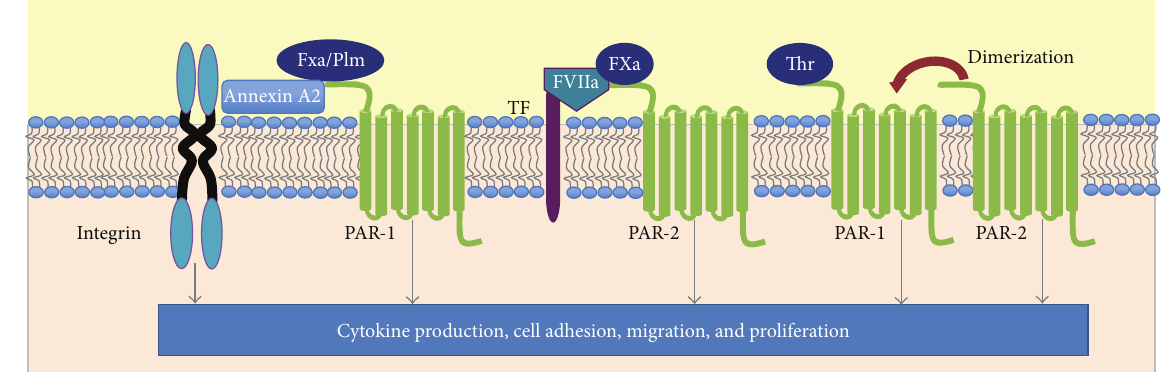
Figure 2: PAR signalling by coagulant and fibrinolytic proteases. Thrombin (thr), FXa, FVIIa, and plasmin (Plm) can signal via different combinations of PARs, coreceptors (e.g., 𝛼 9 𝛽 1 -integrin), and adaptors (e.g., annexin A2). Modulation of signalling may also involve PAR